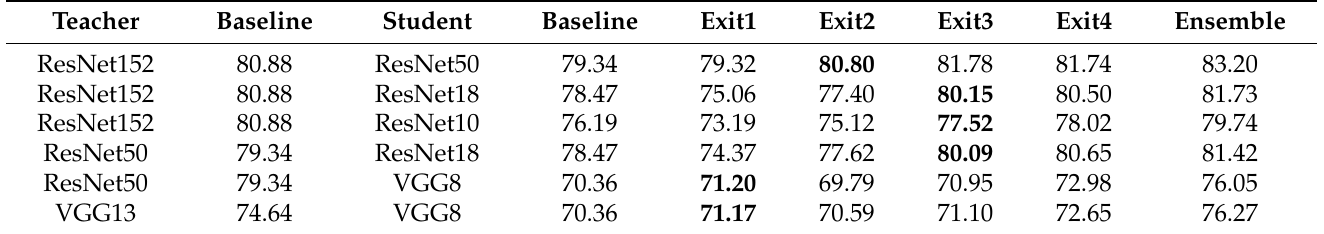
Table 2. Accuracies (%) obtained for the CIFAR100 dataset. The first early exit that exceeds the performance of the benchmark method is marked in bold .